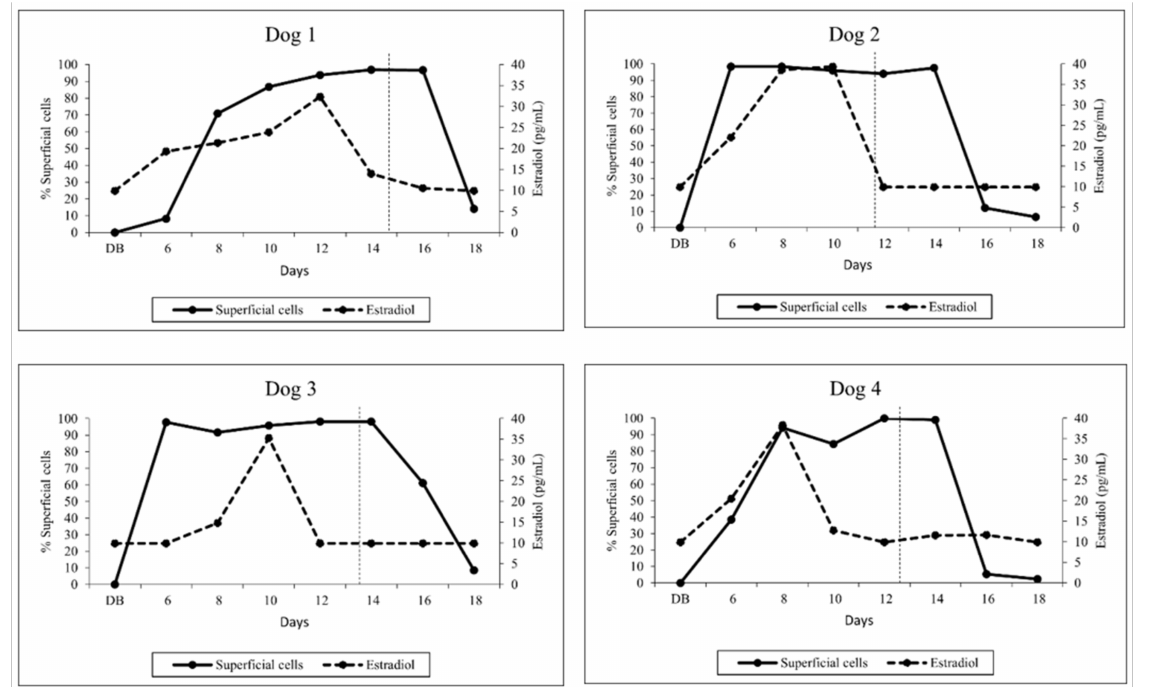
Figure 1. Individual percentage of superficial cells and serum estradiol concentrations of four dogs from the day before implantation (DB) to day 18 after implantation of a 4.7 mg deslorelin implant. The vertical dashed line indicates ovulation date.